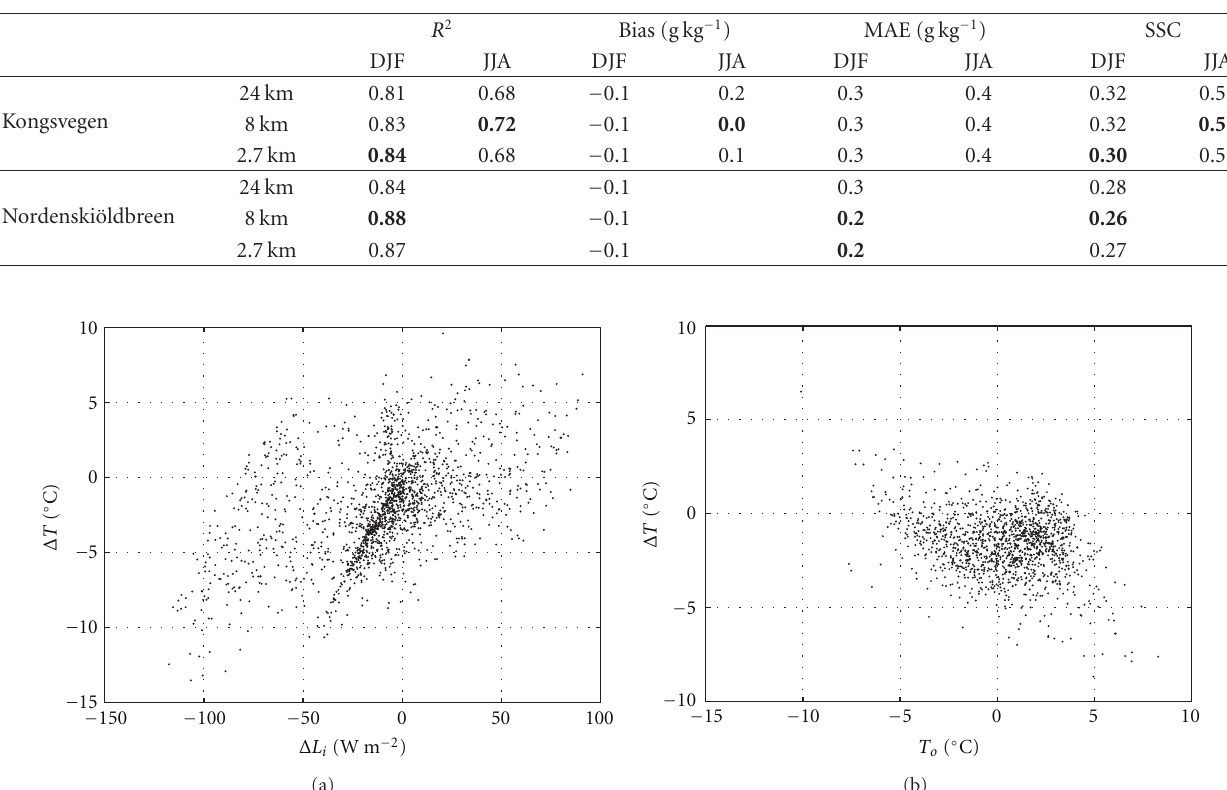
Table 4: Statistical evaluation of specific humidity in summer and winter 2009-2010. Bold numbers indicate the best result for each AWS. Vestfonna data are not used here because of the lack of data during the chosen period.